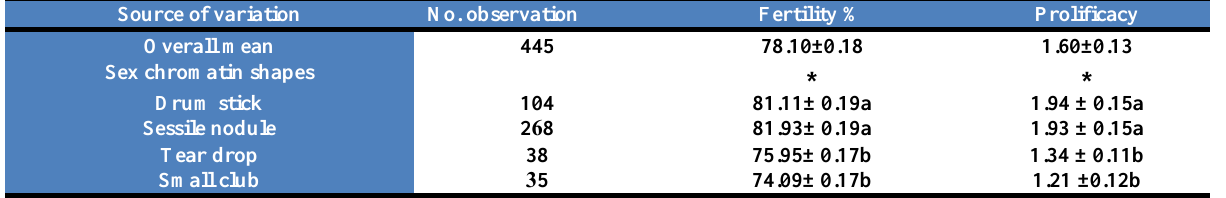
Table, 3: Effect of sex chromatin shapes on fertility and prolificacy.